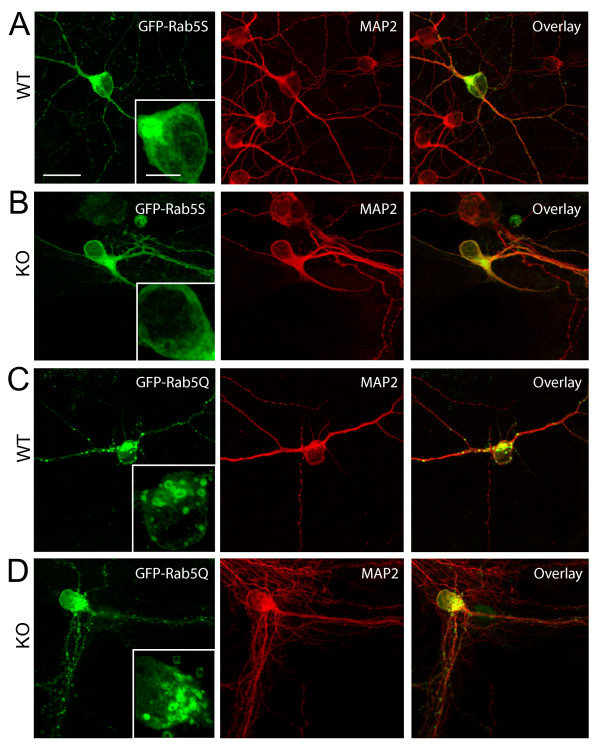
The Enlargement of Rab5-positive endosomes in ALS2-/- neurons may correlate with increased Rab5 activities. Representative images of wild-type (WT) and ALS2-/- (KO) hippocampal neurons transfected with GFP-Rab5S (A and B) or GFP-Rab5Q (C and D). Fragments of soma (inset) were enlarged to reveal the distribution and morphology of Rab5-positive vesicles. Scale bar: 20 μm (main) and 5 μm (inset).